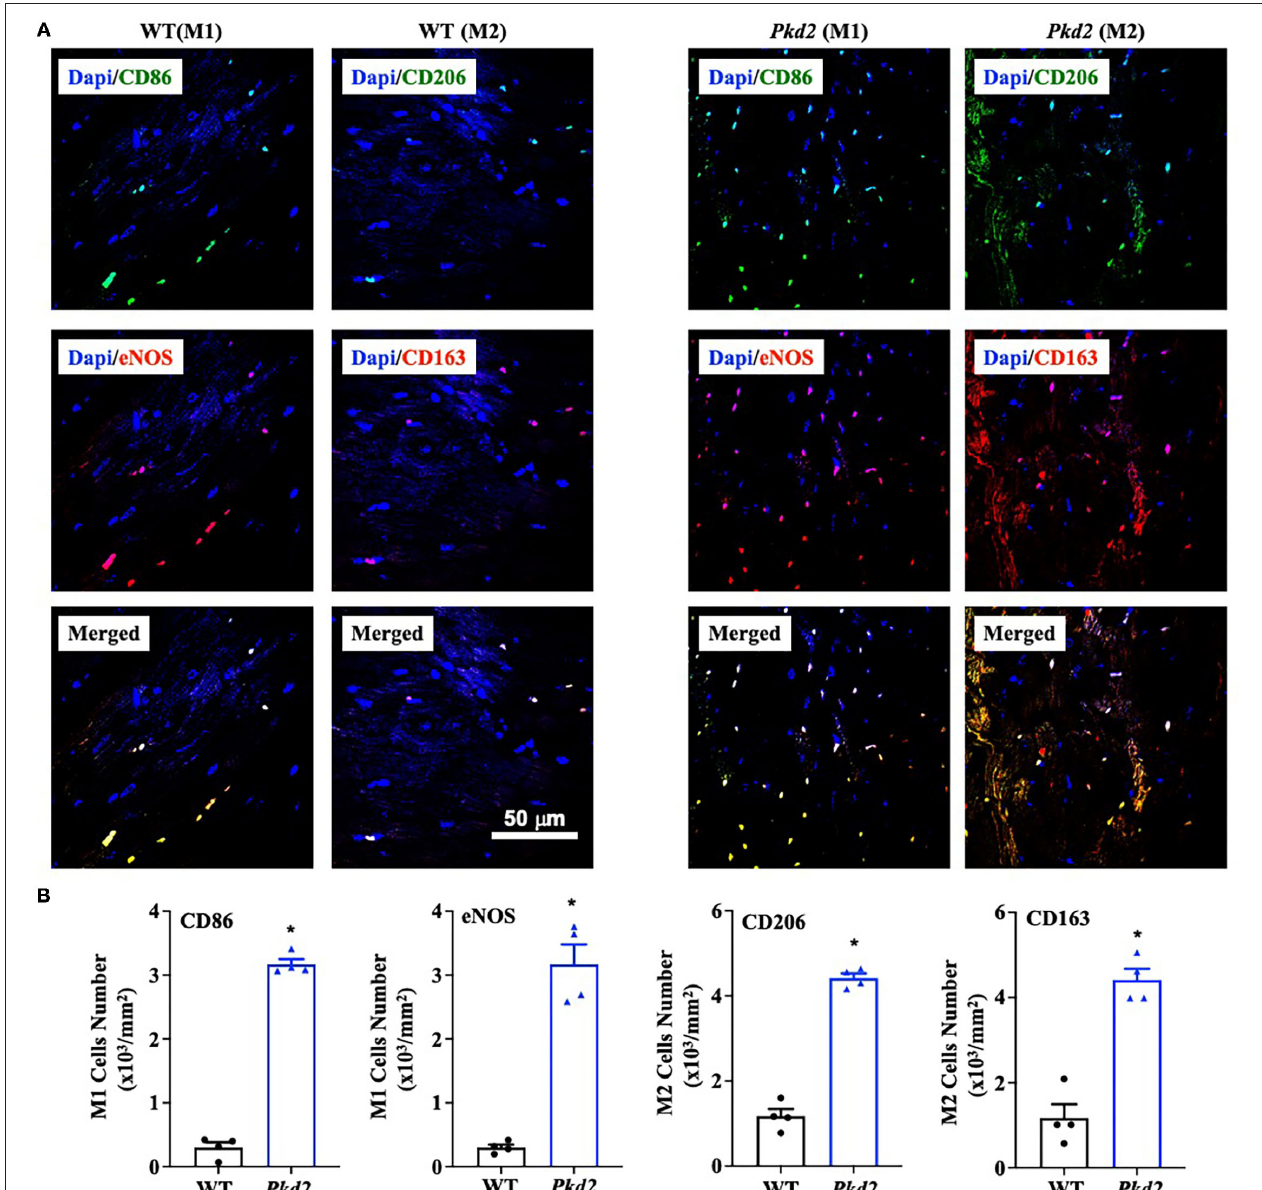
FIGURE 10 | The hearts from Pkd2 -KO mice are significantly infiltrated by macrophages. (A,B) Immunofluorescence staining revealed a significant higher number of macrophages M1 and M2. Image was quantified by binary masking of the red or green fluorescence image. N = 4 mice for each WT and Pkd2 -KO age-matched 6 months old. * p <